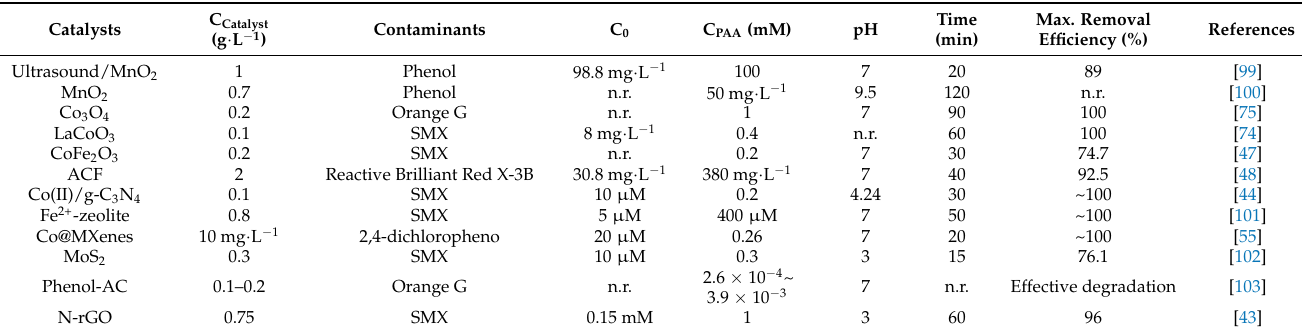
Table 5. Studies of activating PAA in heterogeneous phase